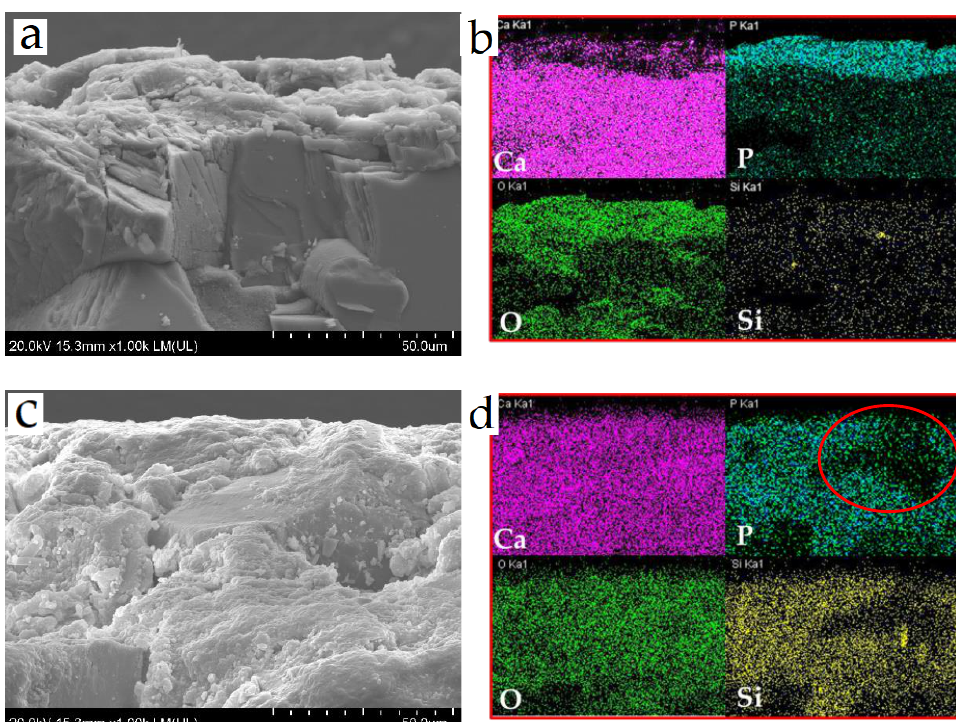
Figure 2. Optical images ( 倍率 = magnification) and FESEM results of specimens’ surface: ( a ) Micro- scope image of DM surface; ( b ) FESEM micrograph of DM surface; ( c ) Microscope image of H1 surface; ( d ) FESEM micrograph of H1 surface; ( e ) Microscope image of H2 surface; ( f ) FESEM mi- crograph of H2 surface.